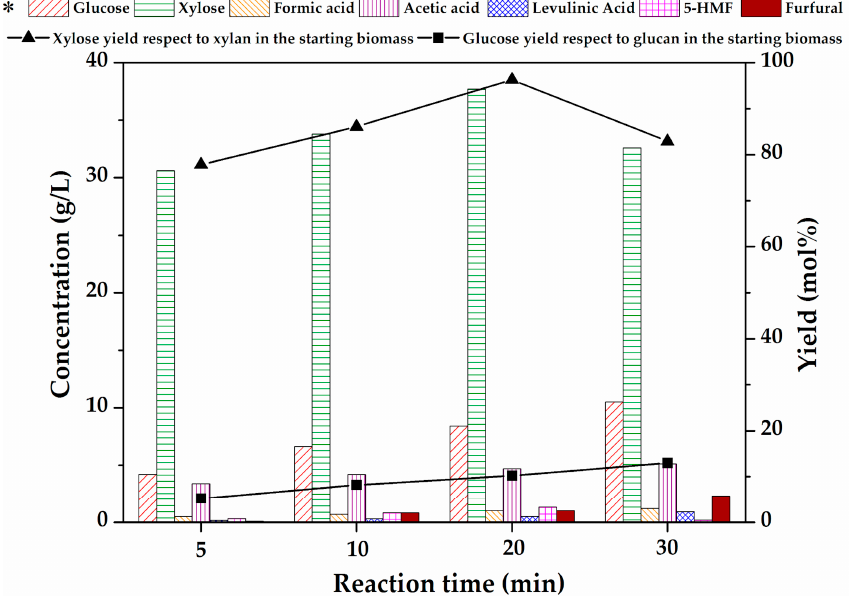
Figure 3. Effect of reaction time on xylose and glucose yields (mol%) and on by-product (g / L). Reaction conditions: 17 wt% biomass loading, 160 ◦ C, Amberlyst-70 / Arundo donax L. weight ratio concentration (g/L). Reaction conditions: 17 wt% biomass loading, 160 °C, Amberlyst-70/ Arundo 0.2 wt / wt (* Compounds donax L. weight ratio 0.2 wt/wt (* Compounds concentration).